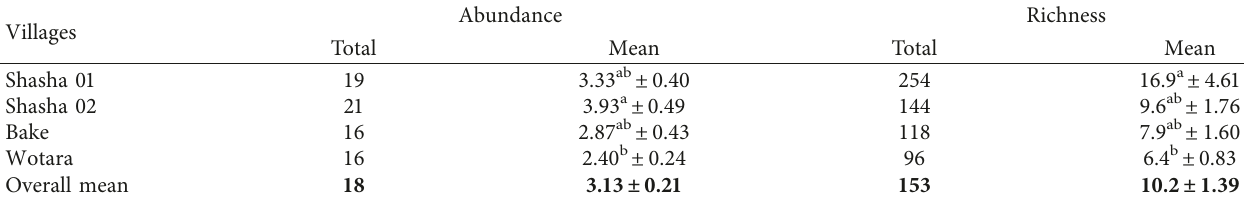
Table 2: Mean woody species richness and abundance per plot at the study